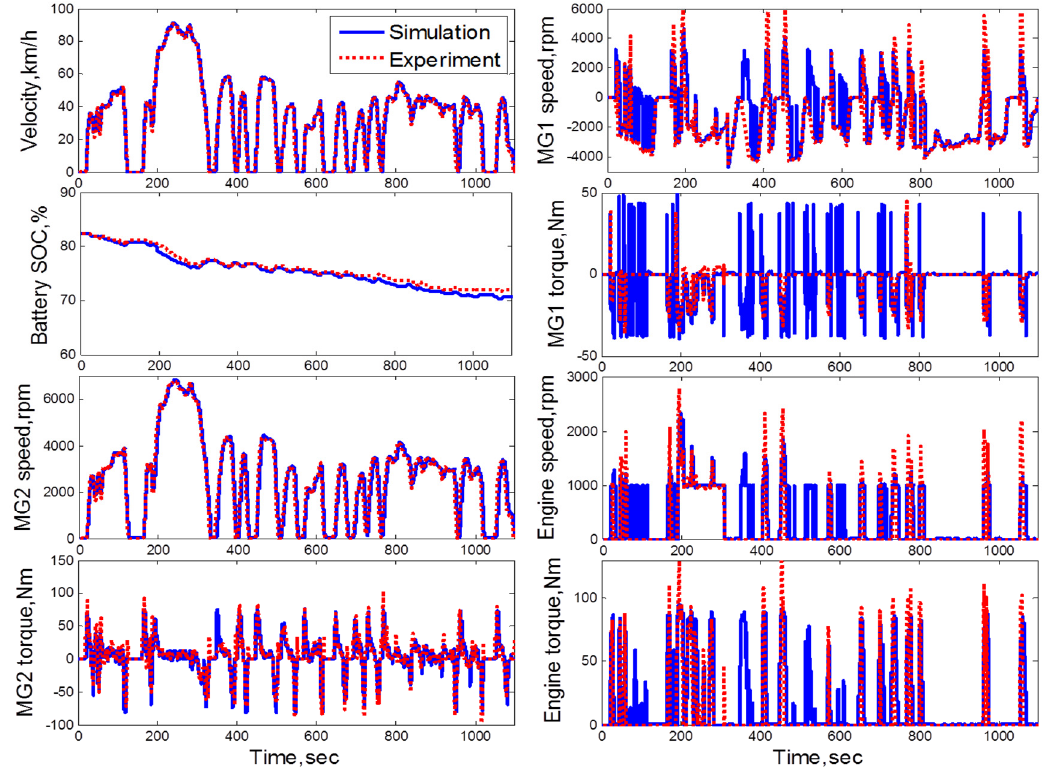
Figure 4. Validation of the PHEV simulator in FTP-72 driving cycle. SOC: state of